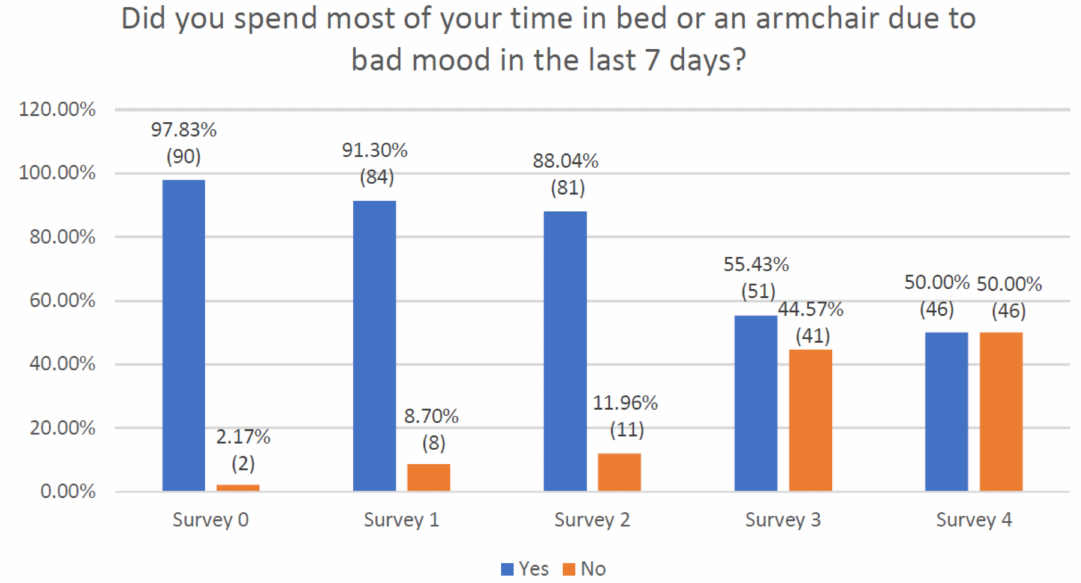
Figure 5. Declaration of respondents regarding passive spending of time resulting from a bad mood. A similar question was asked about the need for help while eating meals (Figure 6). Initially, this requirement stood at 48% but then fell and remained stable at around 30%.